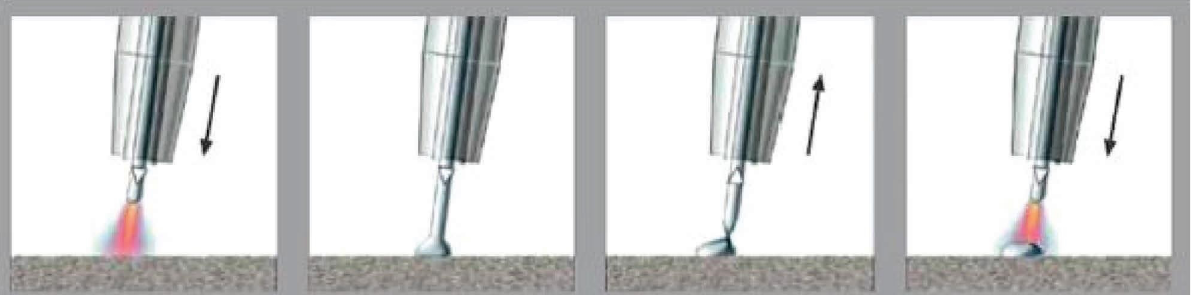
Figure 1: Working principle of CMT welding [4].